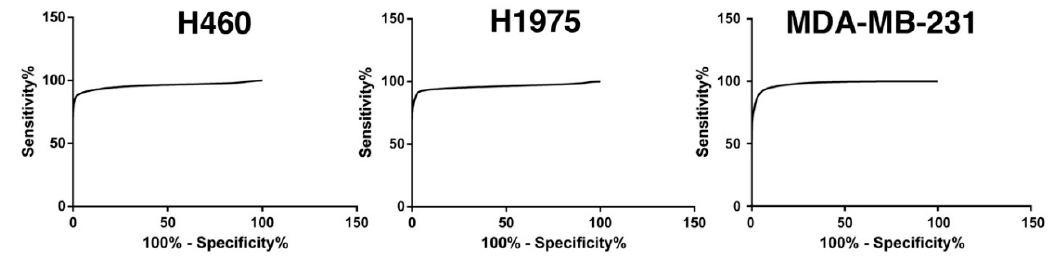
Figure 3. ROC curves obtained analyzing the 2-NBDG positivity of WBC and tumor cells in spike-in samples. See text for more details.